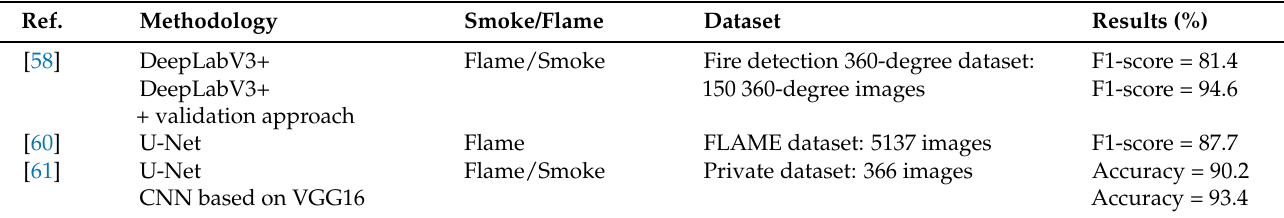
Table 3. Fire segmentation using deep learning methods for UAVs.